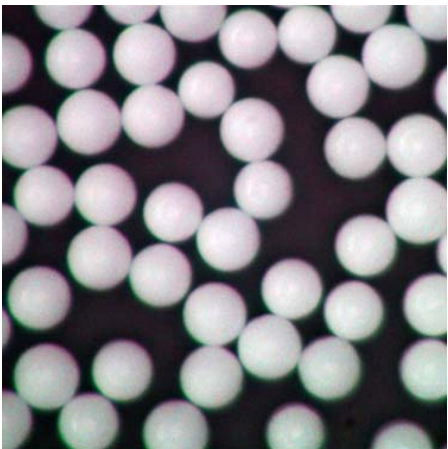
Figure 3. Particles made by Cospheric; particles of all available size classes (1 nm to 13 mm) are equally monodisperse, Reprinted with permission from ref. [194], Copyright 2021 Cospheric.